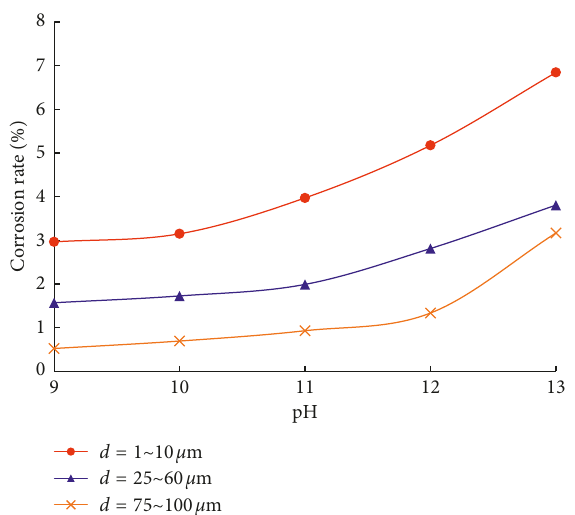
Figure 4: pH versus corrosion rate of shale powder with different